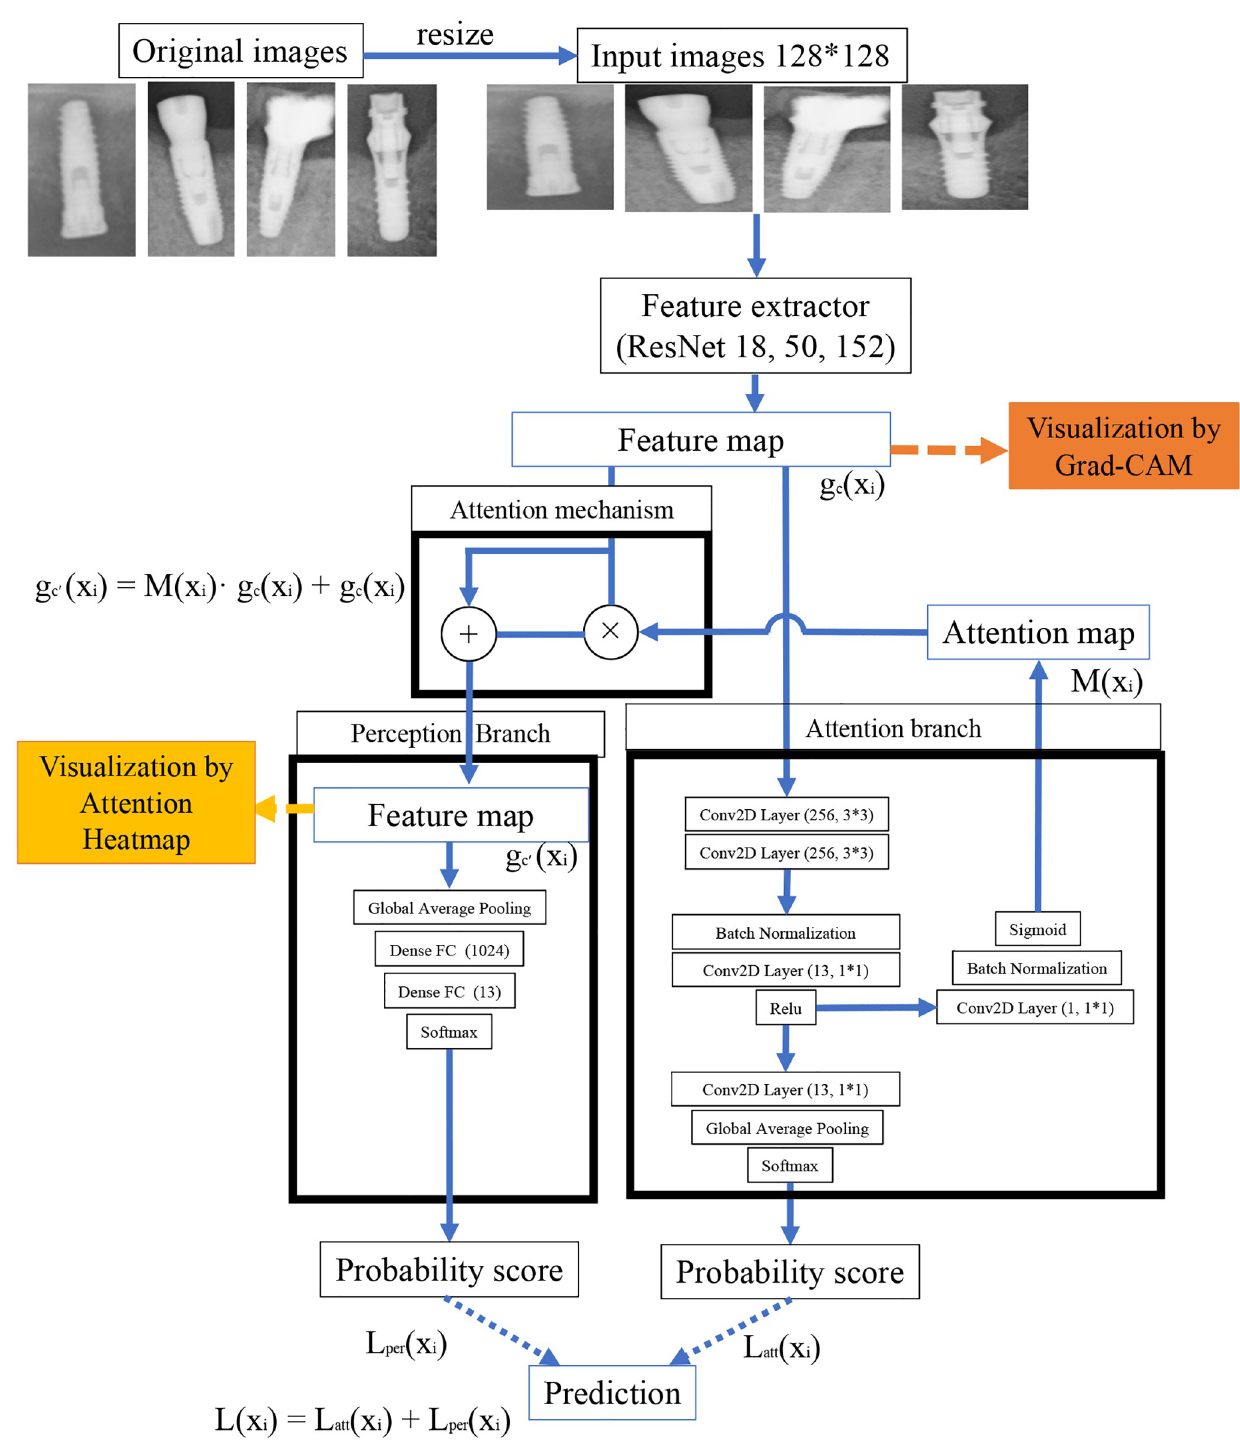
Fig 1. Schematic diagram of the attention branch network used in this study.